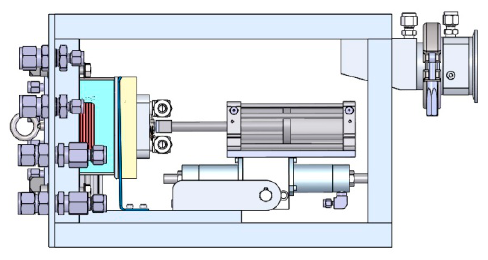
Figure 7. The target placed for dissolution.